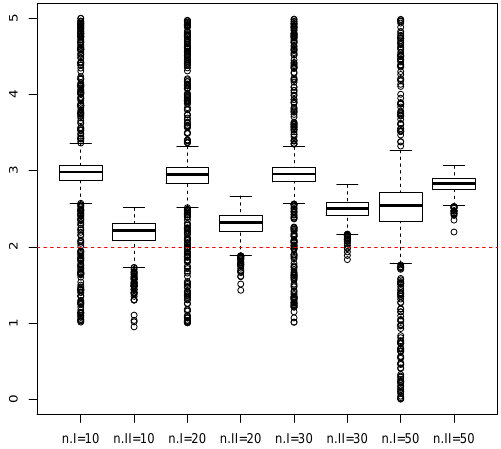
Figure 4. The boxplots of 1000 Bayes estimates of b 1 , where “n.I” and “n.II” indicate that procedures BE-I and BE-II are implemented with sample size n , respectively.